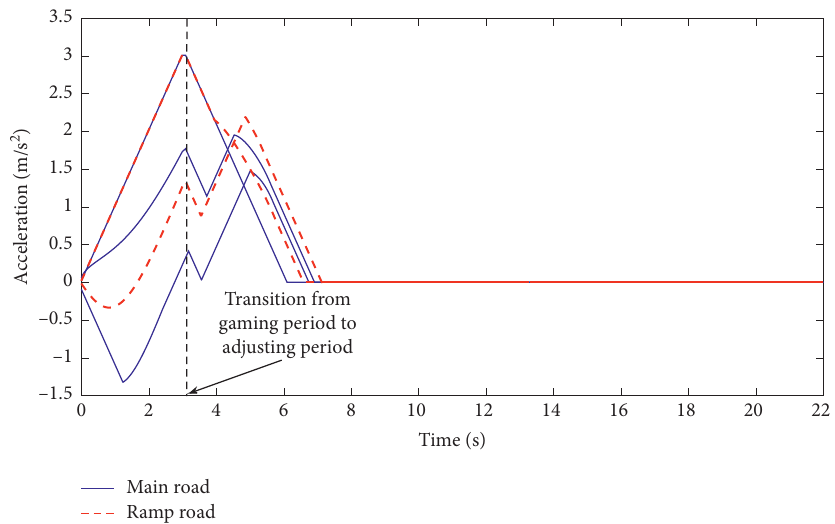
Figure 8: Acceleration of vehicles for Case Study